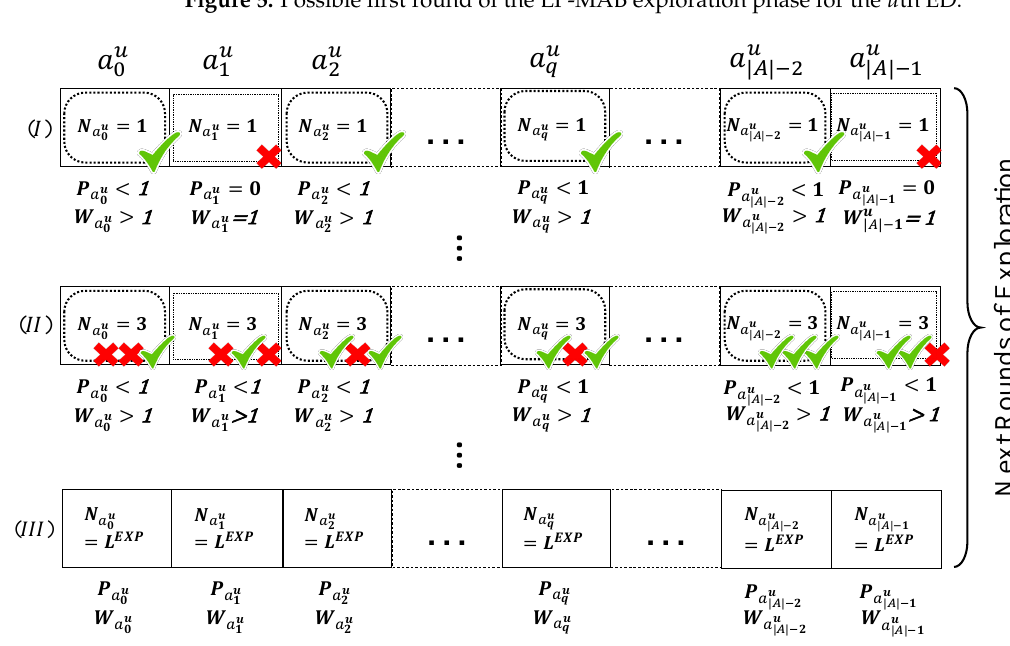
Figure 6. Possible next rounds of the LP-MAB exploration phase for the u th